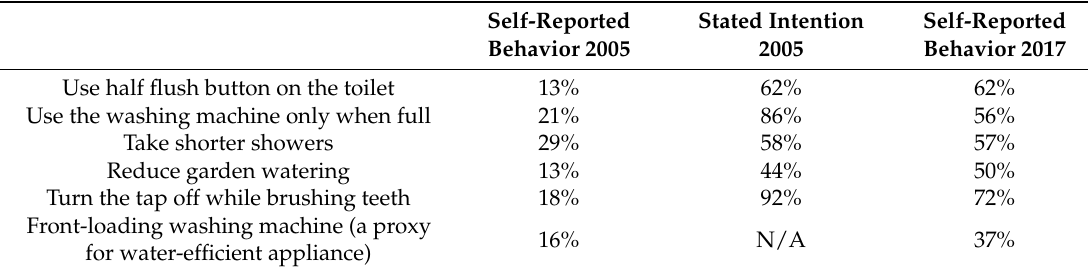
Table 1. Rates of self-reported water conservation behaviors in Sydney 2005 and 2017. First two data columns are from Randolph and Troy [75]. The last data column is based on a survey of 406 households in Sydney by the authors in